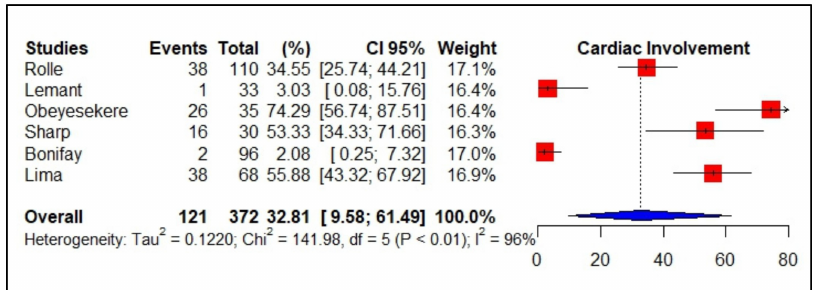
Figure 2. Forest plot comparison of the frequency of cardiac events in patients with chikungunya. Legend : CI—confidence